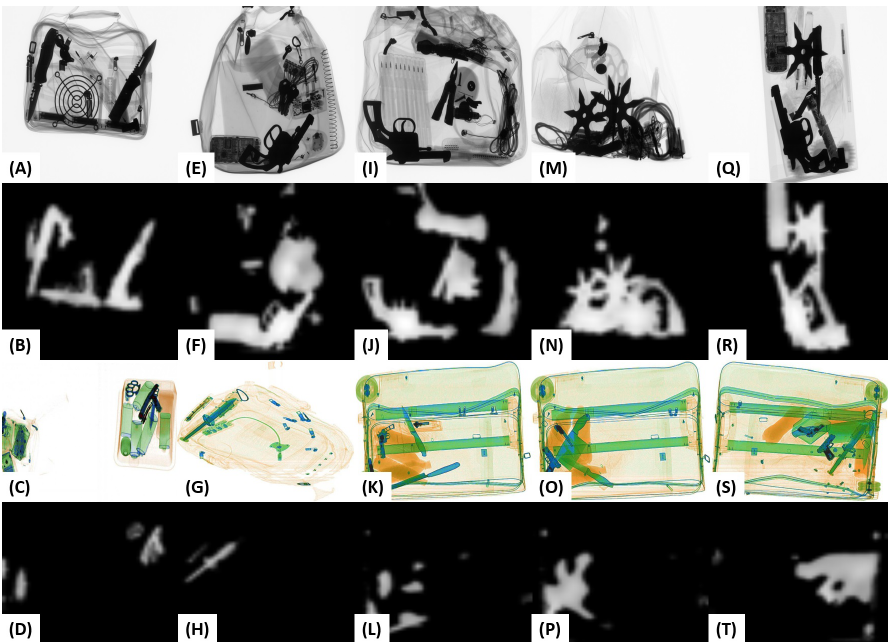
Figure 6. Saliency maps produced by the proposed salient feature extractor on both GDXray [15] and SIXray [14] datasets are shown in ( A – T ). Also, the first and third row show the original scans.